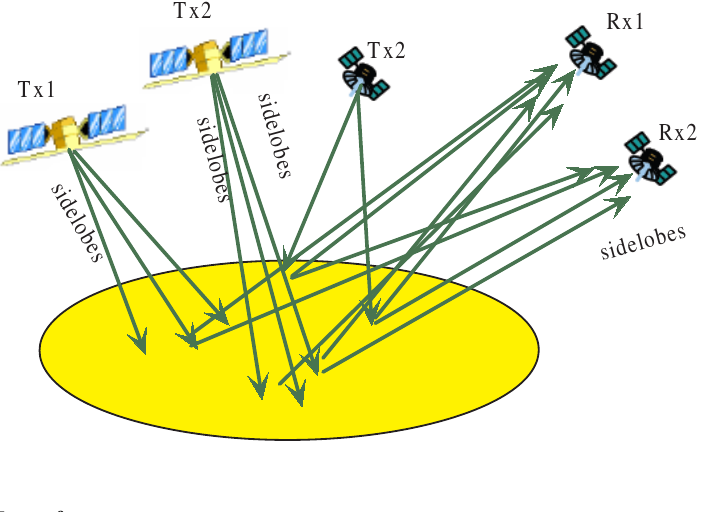
Figure 1. The radar-to-radar interferences in a distributed radar sensor